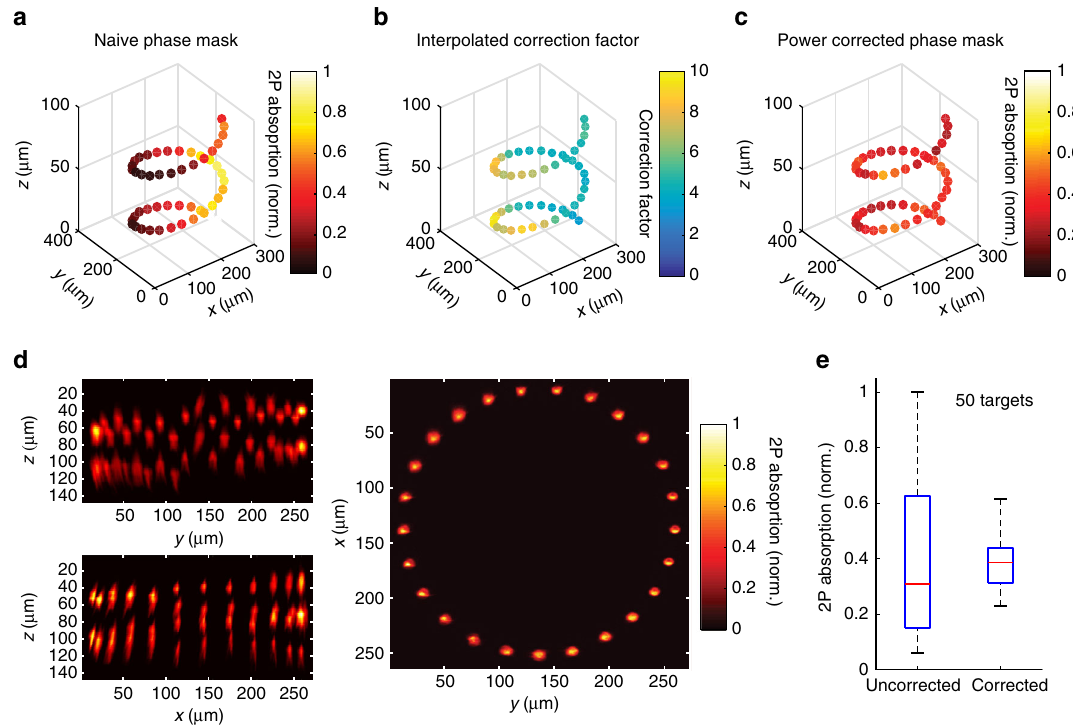
Fig. 7 Power corrected 3D-SHOT simultaneously illuminates 50 spots. a Uncorrected simultaneous 3D-SHOT with a hologram targeting 50 spots in a spiral pattern, occupying 50 individual z- planes. Spots are color coded by normalized 2P absorption in each spot (measured with a sub-stage camera). b Correction factor computed for each spot via 3D power interpolant. c Measurements of 2P-induced fl uorescence with 3D-SHOT, and a power-corrected hologram targeting the same locations as in a . d Mean intensity images of power-corrected 50 spot spiral hologram showing ( z , y ) (top left), ( z , x ) (bottom left), or ( x , y ) (right) projection views. e Box plots showing the variance in normalized 2P absorption from each spot within the corresponding hologram before and after power correction ( p < 1 × 10 − 12 , F -test of equality of variances, error bars correspond to range, red line is median, n = 50